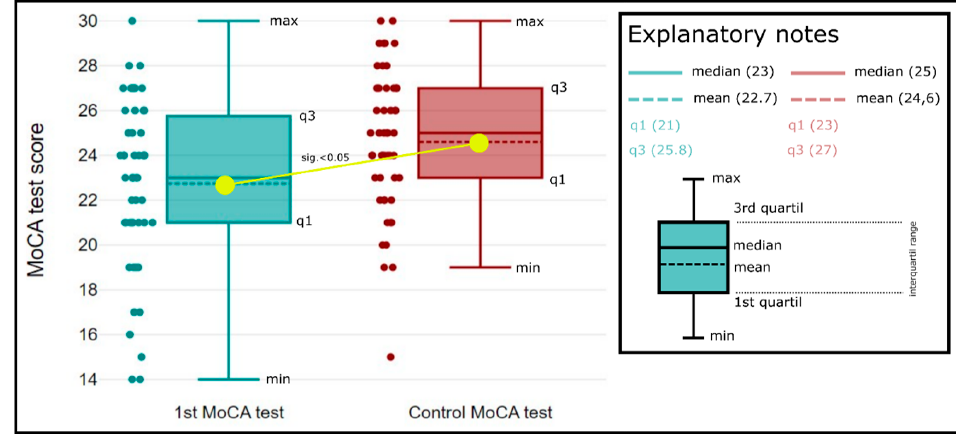
Figure 2. Box-plot diagrams. Comparison of total MoCA score at discharge (green) and 6 months after stroke (red). Mean total MoCA score was significantly increased after 6 months ( p -value < 0.05). Analysis of follow-up MoCA scores after 6 months revealed that the MoCA score